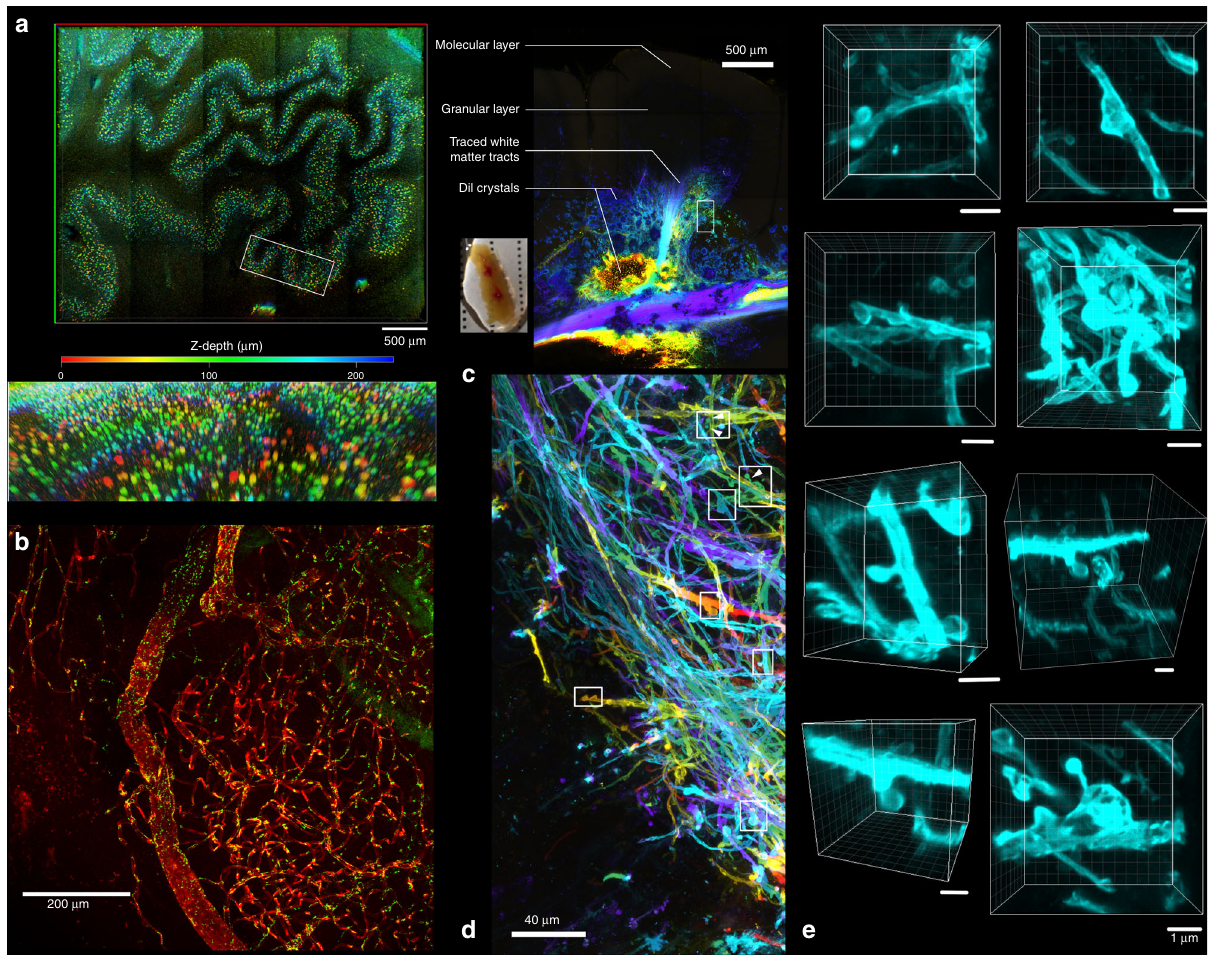
Fig. 2 Non-immunohistochemical staining with tissue clearing on formalin- fi xed brain tissues. a Colour depth-coded image with maximum intensity projection of a piece of 1-mm-thick medulla block stained with cresyl violet and cleared with OPTIClear (z-stack depth = 228.83 µ m). Lower image showing a zoomed and tilted view of area outlined by the white box. b A piece of frontal cortical block immunostained for ZO-1 (green) and counterstained with DyLight 649-labelled Lycopersicon esculentum lectin (red). c DiI crystals were inserted into a cerebellar folium to trace the fi bres up to the granular layer, followed by tissue clearing with OPTIClear for 6 h at 37 °C. Most of the fi bres traced were mossy fi bres. The inset shows the gross appearance of the sample with red crystals of DiI inserted within the OPTICleared sample. d Enlarged view of the white boxed region in a. with colour depth-coding (Z-depth 151.09 μ m). e Z -stack images of dendritic spine-like projections visualised in areas outlined by white boxes. Scale bars, 1 μ